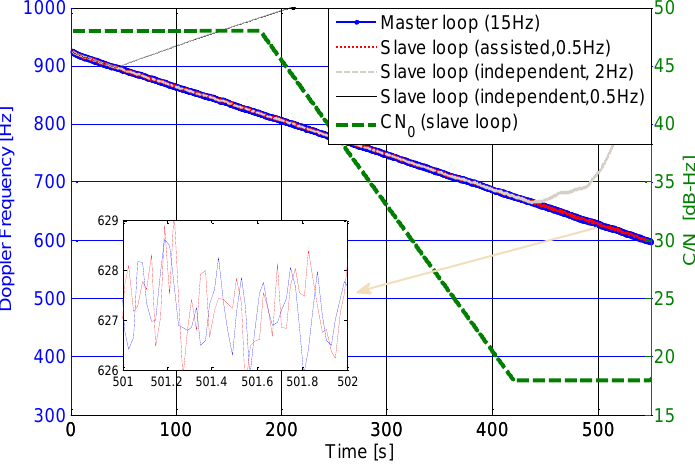
Figure 13. Tracking performance comparisons in a software GPS